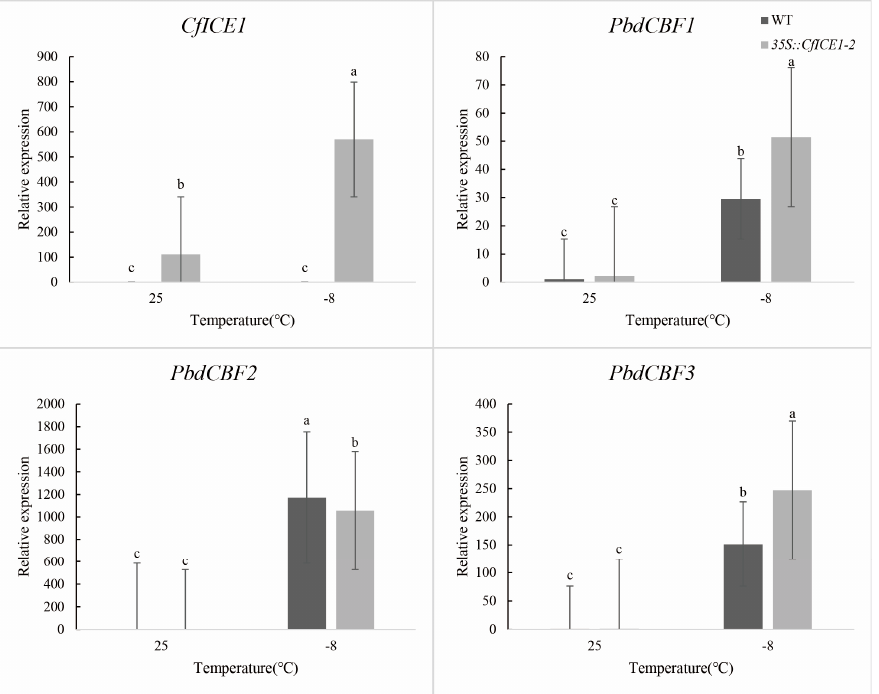
Figure 10. Changes in CfICE1 , PdbCBF1 , PdbCBF2 and PdbCBF3 gene expression under cold stress. Each bar indicates the average ± SD (n = 3), and lowercase letters above each bar indicate significant differences ( p ≤ 0.05).